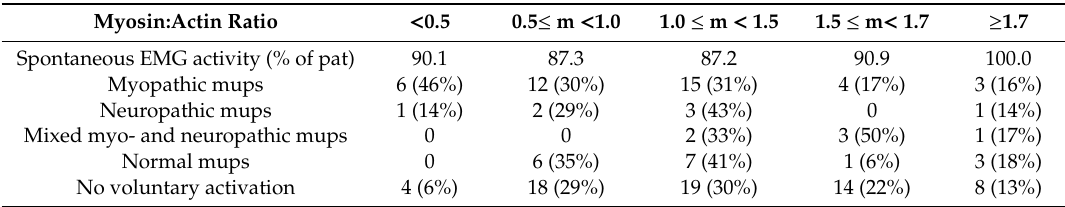
Table 2. Summary of age, anthropometric, gender and electrophysiological data in the patient material. Number of patients, number of patients with values outside defined confidence limits and % of patients with findings outside defined limits are given. Values are means ± SD. Figure 6. Plot of ratio between amplitude of direct and indirect responses for different myosin:actin groups. The myosin:actin ratios measured in biopsies from the same occasion and muscle are presented in a total of 29 patients in groups separated into severe ( < 0.5), high (0.5– < 1.0), moderate (1.0– < 1.5) and small (1.5– < 1.7) preferential myosin loss as well as in patients with normal M:A ratios ( > 1.7). Table 3. Spontaneous electromyographic (EMG) (fibrillation potentials and positive sharp waves) and motor unit potentials (mups) in patient subgroups divided in relation to preferential myosin loss. Myosin:Actin Ratio < 0.5 0.5 ≤ m <